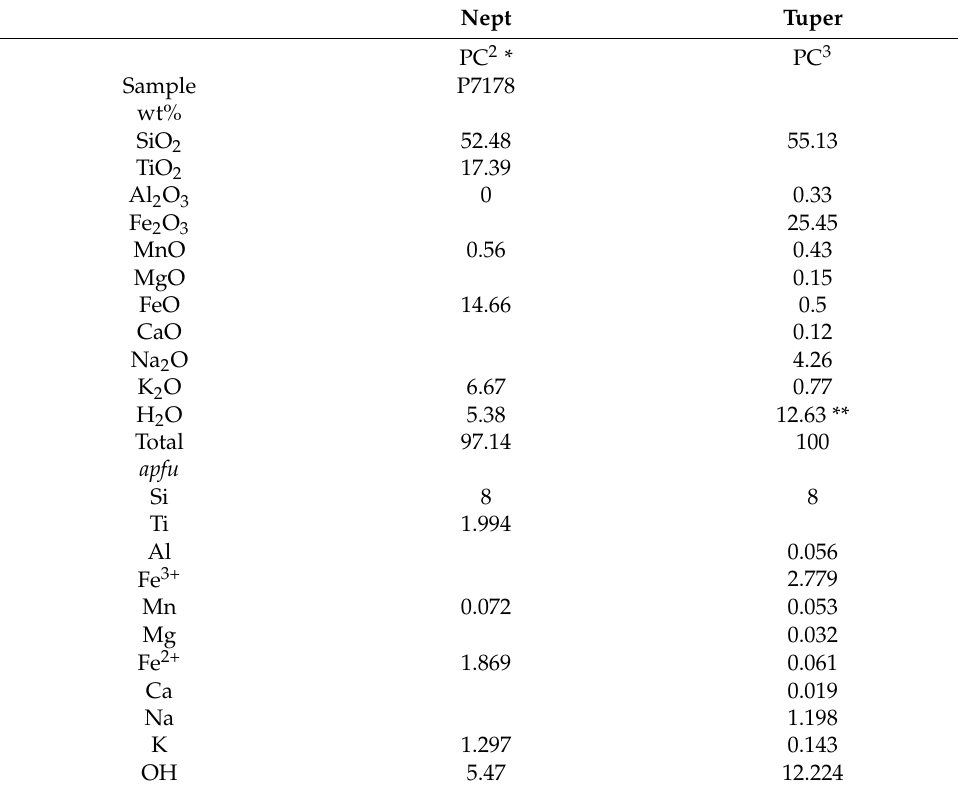
Table 7. Phyllosilicate